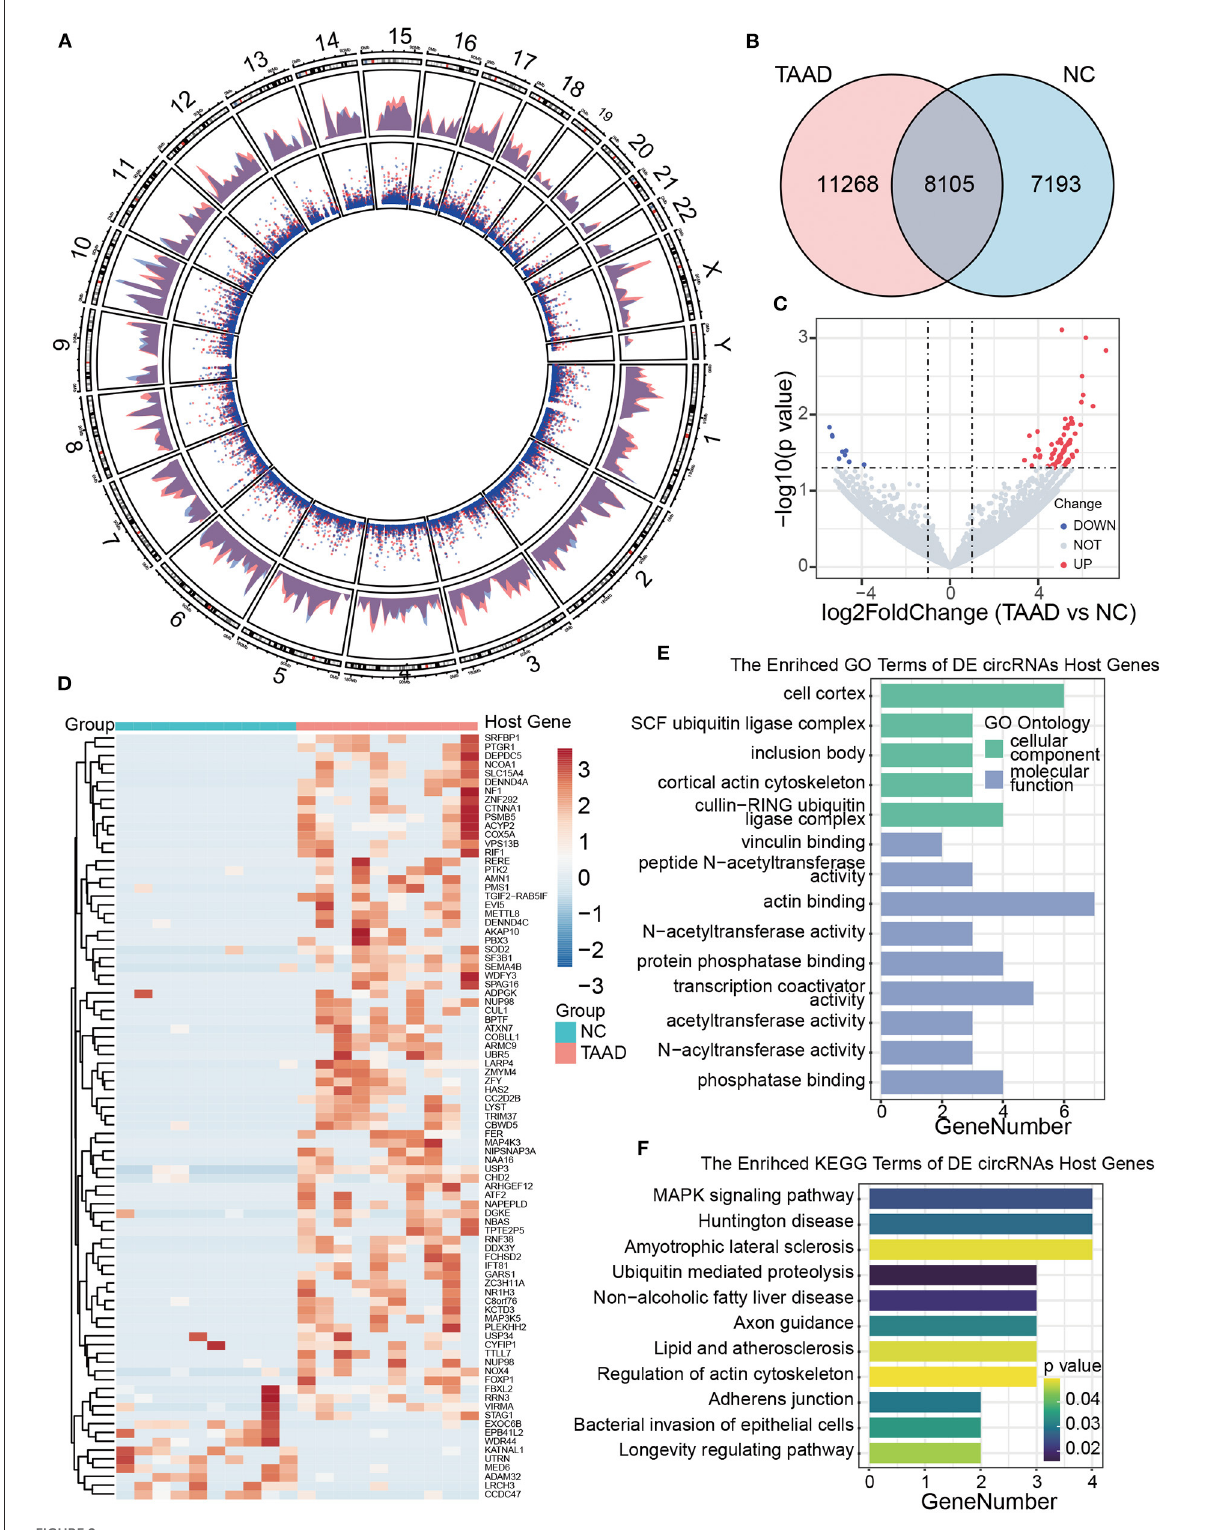
FIGURE2 Profiles of circRNAs of patients with TAAD and healthy controls. (A) Distribution of the circRNAs on human chromosomes. A circos plot diagram shows the locations of the circRNAs on human chromosomes. The outer and inner layers indicate the distribution and counts of